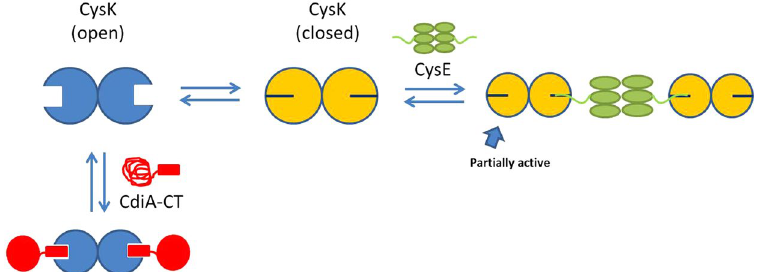
Figure 7. Formation of CS and CysK:CdiA-CT complexes. CysK exists in two conformations: an open, inactive conformation and a closed one that was isolated as a complex with substrate analog 31 . Structural data 42 demonstrate that CdiA-CT binds to the open conformation of CysK. Binding is slow and is limited by a large conformational change, which likely corresponds to CdiA-CT folding to its active conformation. Here, we propose that CysE preferentially binds to CysK in the closed active-site